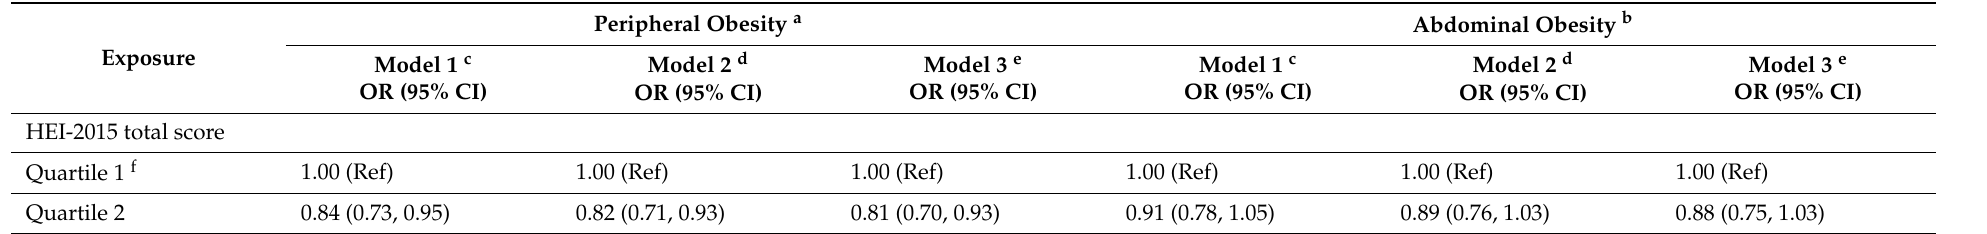
Figure 2. Spearman correlations between heavy metals and the components of the HEI-2015 total score. Table 2. Association of HEI-2015 total scores and heavy metals with obesity in NHANES 2007–2018 ( n =